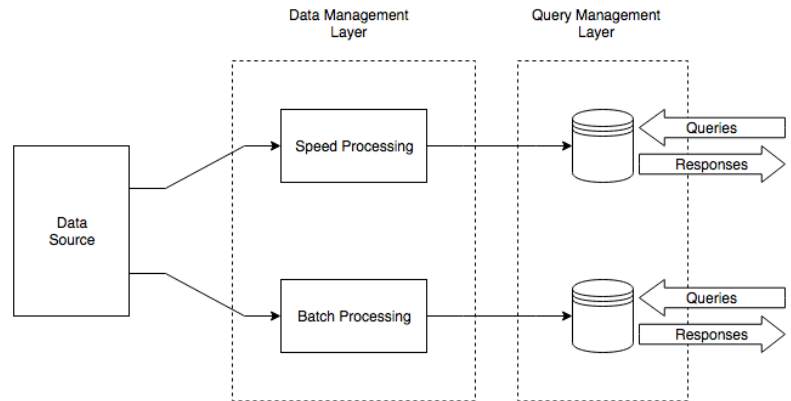
Figure 7. Example of a lambda